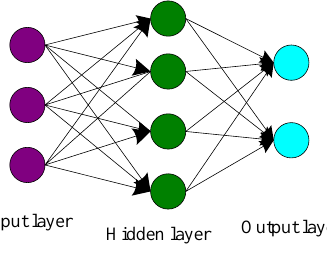
Figure 2. Typical BP neural network structure.